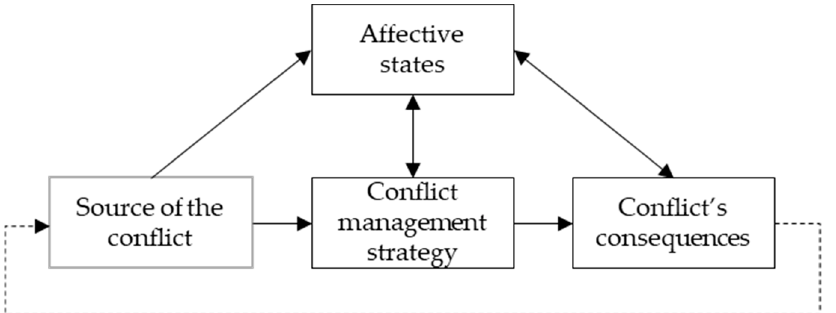
Figure 1. Conflict